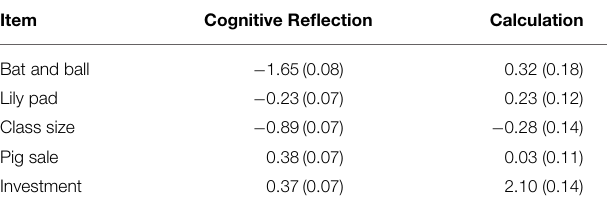
TABLE 4 | Model difficulty parameters (standard errors) for each CRT